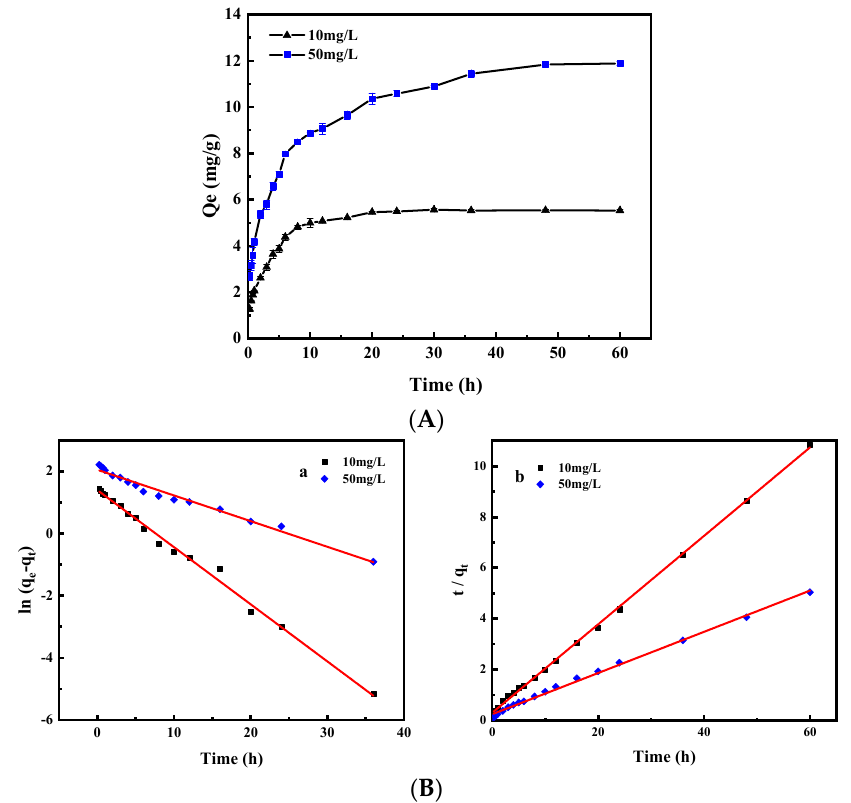
Figure 6. ( A ) Effect of adsorption time on adsorption performance ( C 0 = 10 and 50 mg/L, pH = 2, and temperature = 25 °C); ( B ) Linear kinetic plots of pseudo-first model ( a ) and pseudo-second model ( b ) for Cr(VI) adsorption by MHDB. Table 1. The kinetics parameters for the adsorption of Cr(VI) by MHDB. C 0 Pseudo-First-Order Pseudo-Second-Order mg/L q e